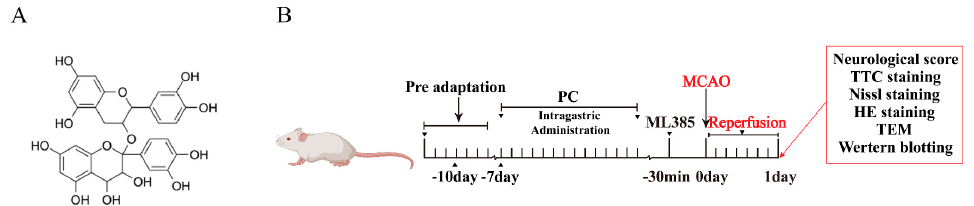
Figure 1. Chemical structure of procyanidins ( A ) and the experimental plan ( B ).